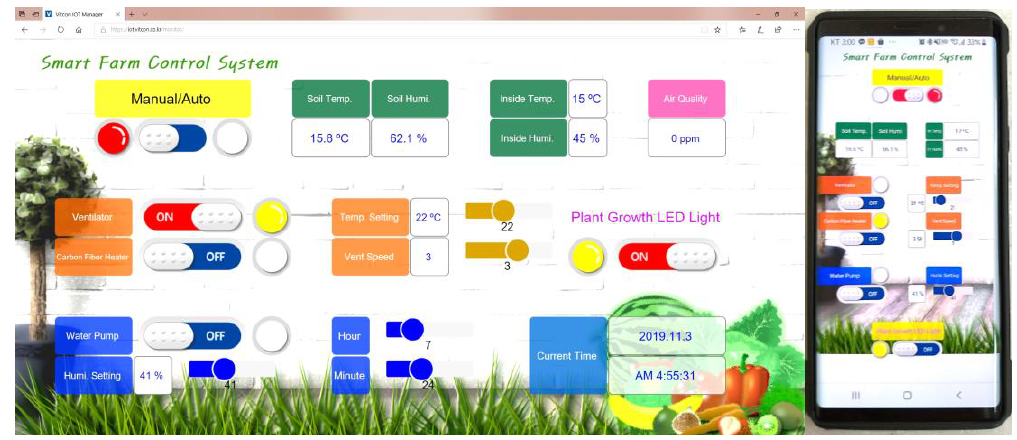
Figure 10. Web and App programming design screen.